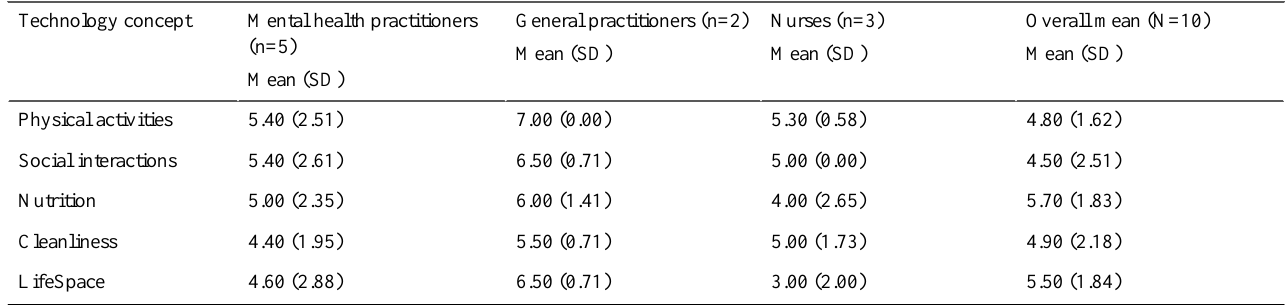
Table 3. Mean rating of technology concepts (1=strongly disagree, 7=strongly